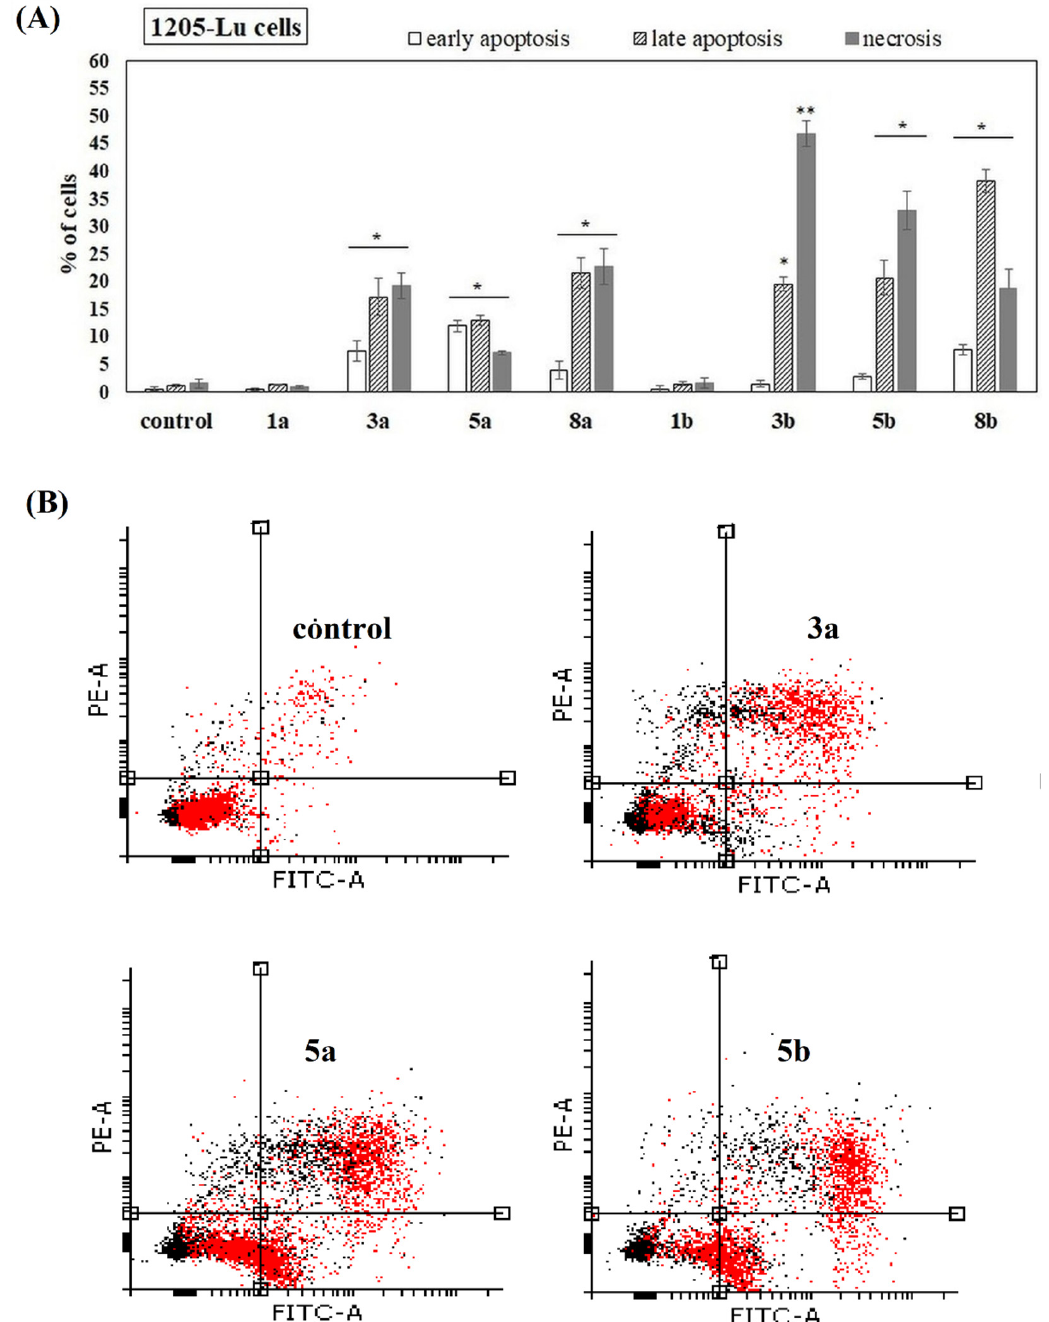
Figure 6. Induction of apoptosis in 451-Lu cells in the presence of the studied compounds. Cells were cultured for 72 h in the presence of the studied chemicals (at 100 μ M). The percentage of ne- crotic, early and late apoptotic cells was shown. The statistical significance was determined (* p < 0.05 and ** p < 0.001) ( A ). Representative histograms of events defined after forward and side scatters as cells (red dots) and debris (black dots) are shown ( B ).